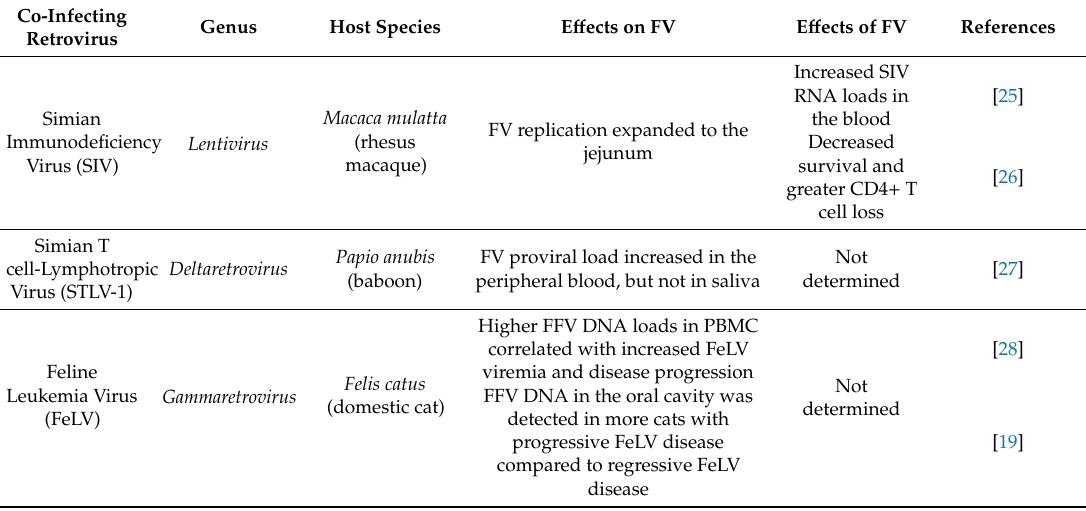
Table 1. Foamy virus (FV) and retrovirus co-infections: their e ff ects on the